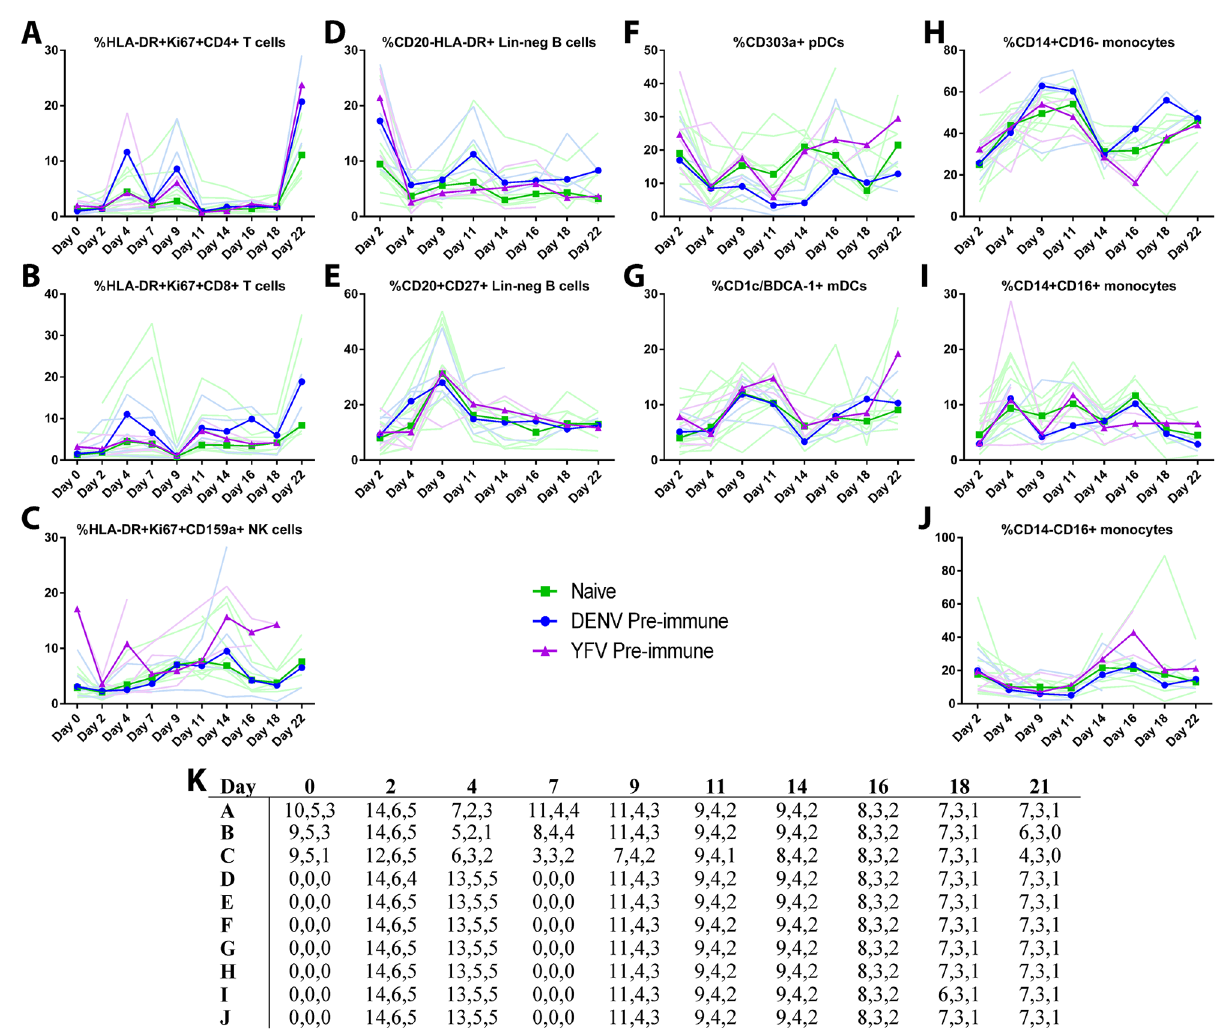
Fig 5. Cell-mediated immune activation during acute ZIKV infection. Ex vivo wholeblood immunophenotypingwas performed during acute ZIKV infectionin rhesus macaques. Multiparametric flow cytometry was used to identify variousimmune cell subsets, including( A ) activated CD4 + and ( B ) CD8 + T cells; ( C ) activated CD159a + NK cells; ( D ) CD20 - HLA-DR + and ( E ) CD20 + CD27 + Lineage-negative B cells (CD3 - CD14 - CD16 - CD11c - ); ( F ) CD303a + pDCs and ( G ) CD1c/BDCA-1 + mDCs (HLA-DR + CD20 - CD14 - CD16 - ); and ( H ) CD14 + CD16 - , ( I ) CD14 + CD16 + , and ( J ) CD14 - CD16 + monocytes (HLA-DR + CD20 - ). Shownare individualmonkeys (faint lines) as well as medians(bold lines) of na ï ve(green), DENV-immune(blue), and YFV-immune (purple)groups. Day 0 is the day of infection. ( K ) Table displaysthe sample size (n) that met inclusioncriteria for each group (Na ï ve,DENV-immune, YFV-immune) at each time point for each cell subset A-J.